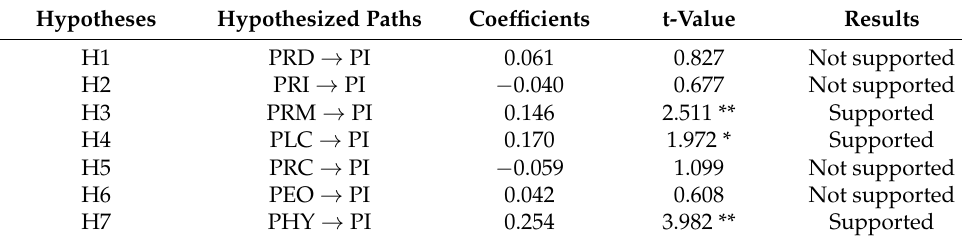
Table 4. Hypotheses testing for Model 1.